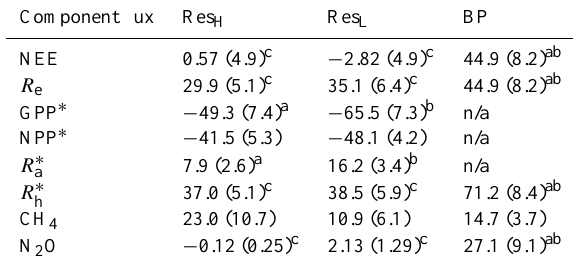
Table 4. Means of measured CO 2 fluxes (mgCm − 2 h − 1 ) includ- ing net ecosystem exchange (NEE), ecosystem respiration ( R e ), gross primary production (GPP), net primary production (NPP), autotrophic respiration ( R a ) and heterotrophic respiration ( R h ), as well as means of measured methane (CH 4 ; µgCm − 2 h − 1 ) and ni- trous oxide (N 2 O; µgNm − 2 h − 1 ) fluxes in restoration treatments with high (Res H ) and low (Res L ) water table level and bare peat (BP); negative and positive fluxes represent uptake and emission, re- spectively; numbers in parenthesis indicate standard error; different letters indicate significant ( P <0.05) differences among